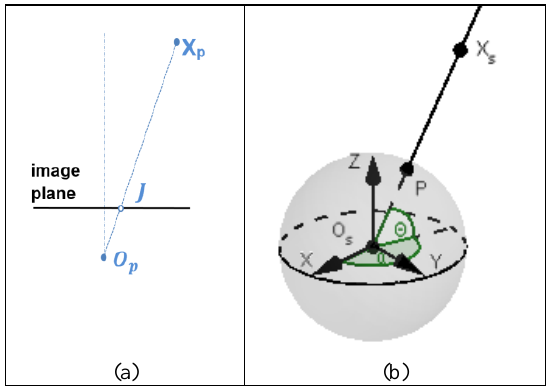
Figure 1. (a) Pinhole camera model. (b) Spherical camera model